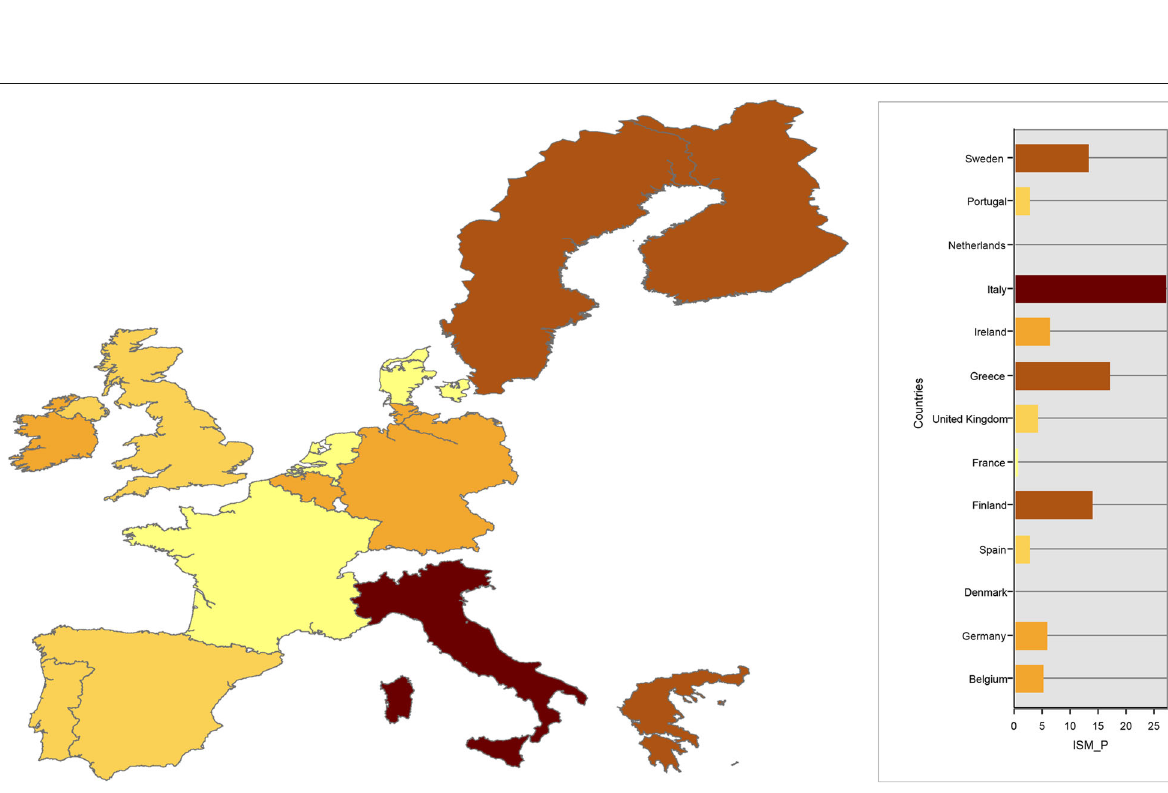
Fig. 10 Detainable remarks percentage for ISM Code for EU15